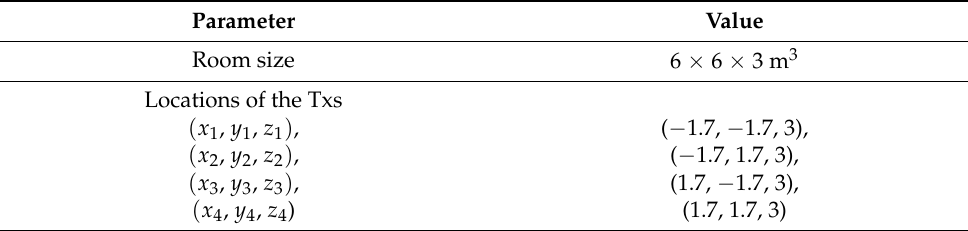
Table 3. The key system